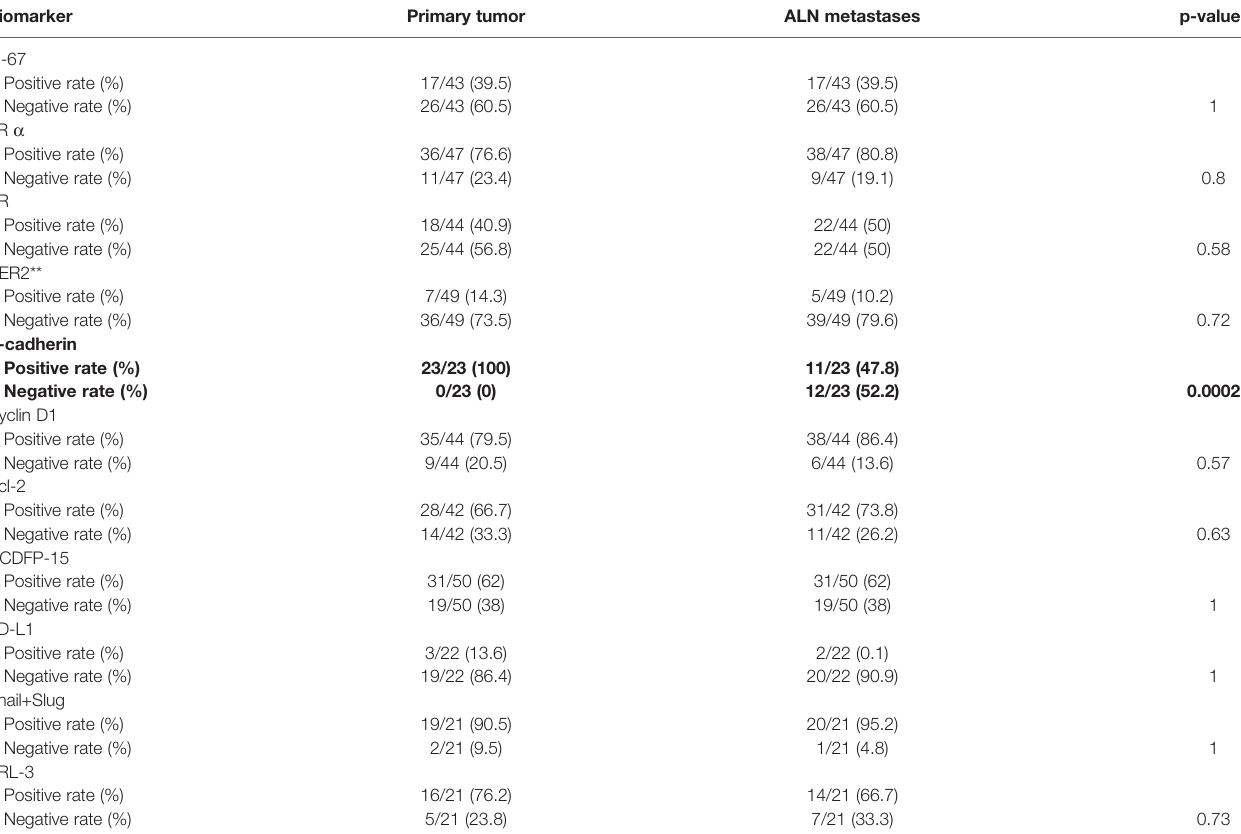
TABLE 3 | The comparison of biomarker expression pro fi les in the breast PTs and ALN metastases presenting a total of positive and negative cases among PTs as well as positive and negative cases among ALN metastases. Biomarker Primary